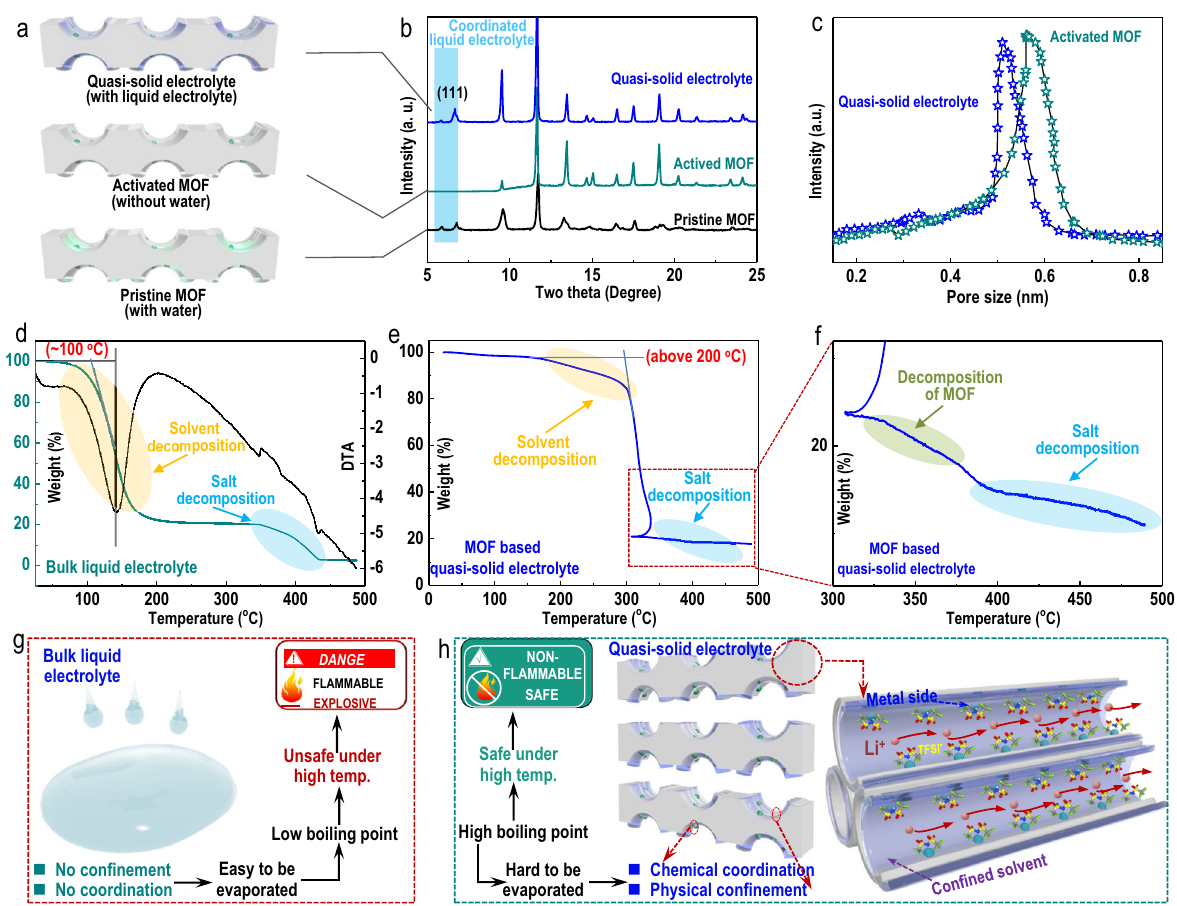
(cid:2) Chemical coordination (cid:2) Physical confinement Fig. 2 Physical characterization of the MOF-based quasi-solid electrolytes. a Schematic illustration of the porous host material precursor used to prepare the electrolytes under different conditions. From bottom to top: pristine MOF (CuBTC-PSS), activated MOF, MOF with a liquid electrolyte coordinated inside its channels (quasi-solid electrolyte)) and the corresponding b X-ray powder diffraction (XRD) patterns of the three kinds of materials. c Pore size distributions of the activated MOF- and MOF-based quasi-solid electrolytes. d Thermogravimetric analysis (TGA) curve of the typical liquid electrolyte (1 M LiTFSI-PC). e TGA curve of the MOF-based quasi-solid electrolyte and f the enlarged version of that TGA curve ( e ). Schematic illustration of g the disadvantages of typical liquid electrolytes and h advantages of MOF-based quasi-solid